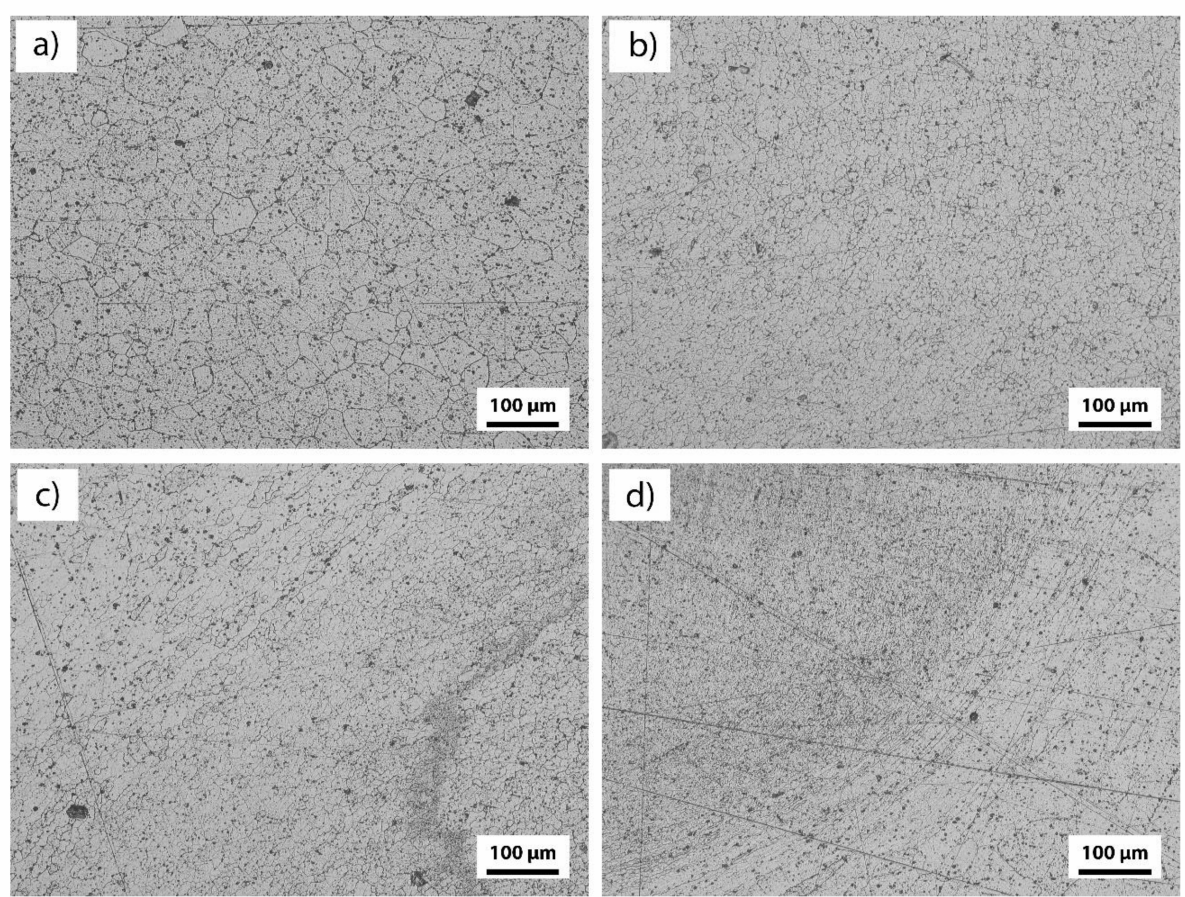
Figure 7. Microstructure of the base material ( a ), nugget zone ( b ), and two transition zones ( c , d ) in specimen